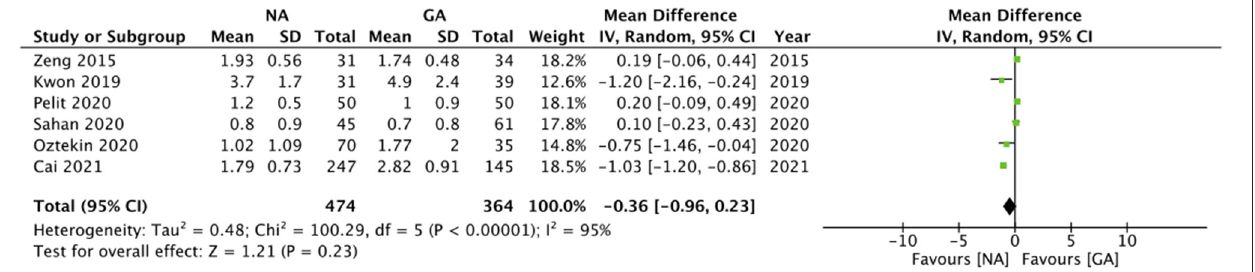
FIGURE 4 | Meta-analysis of 24h pain scores between NA and GA for RIRS.